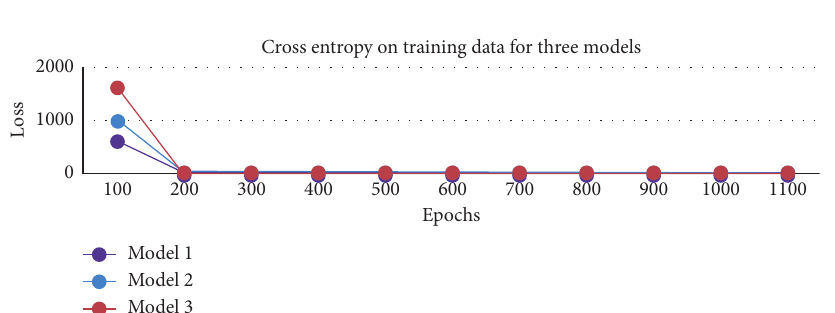
Figure 17: Model 3 training/testing accuracy.